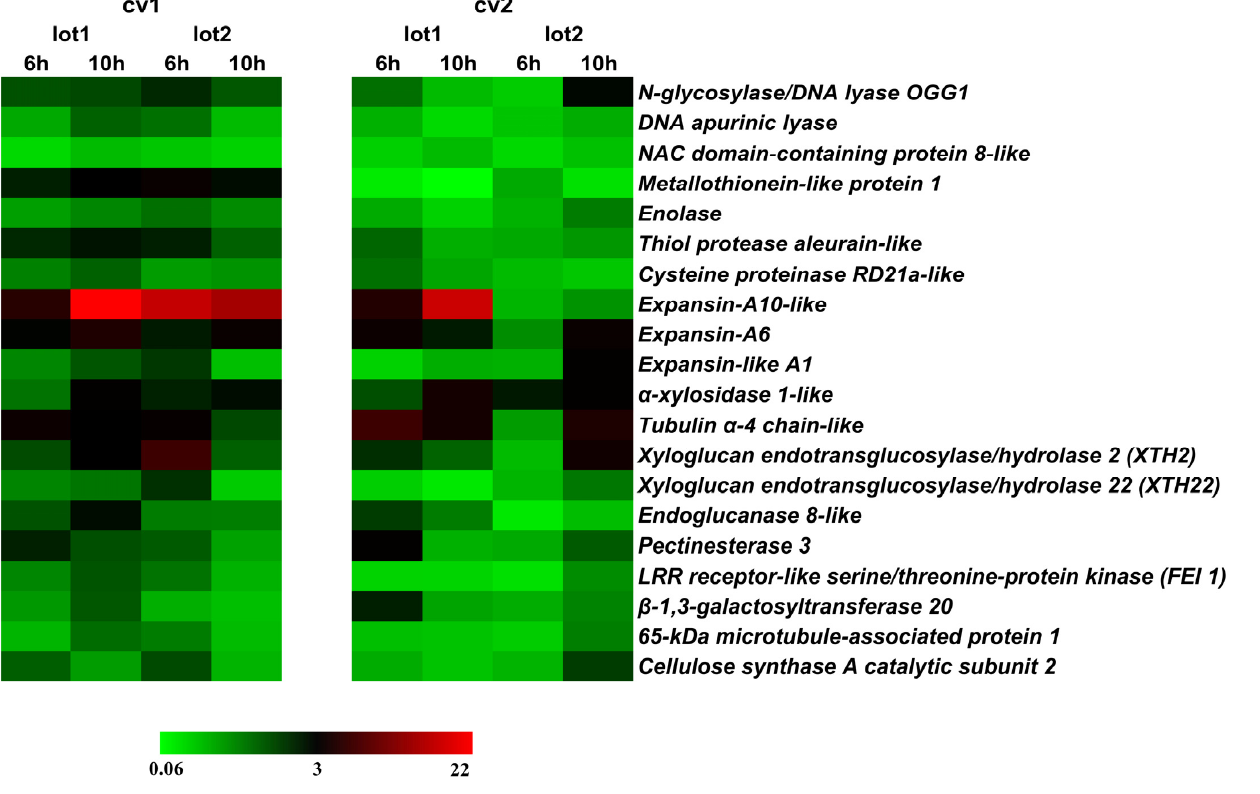
Figure 5. Heatmap of relative expression (2ˆ − ∆∆ CT ) during germination sensu stricto in the embryonic axis in two commercial cultivars (cv1-BRS133 and cv2-MG/BR 46 (Conquista)) and their respective seed lots (L1: lot 1 and L2: lot 2). The relative expression was obtained using the Pair-Wise Fixed Reallocation Randomization Test ( n = 6) in relation to the expression of dry embryonic axis.